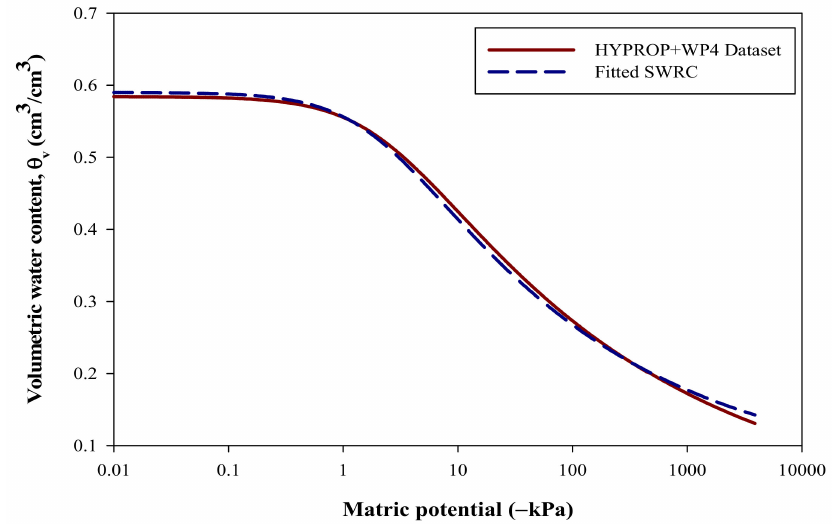
Figure 2. Soil water release curve (SWRC) of silty clay loam soil used in the study and developed by HYPROP evaporation and WP4 dewpoint potentiometer